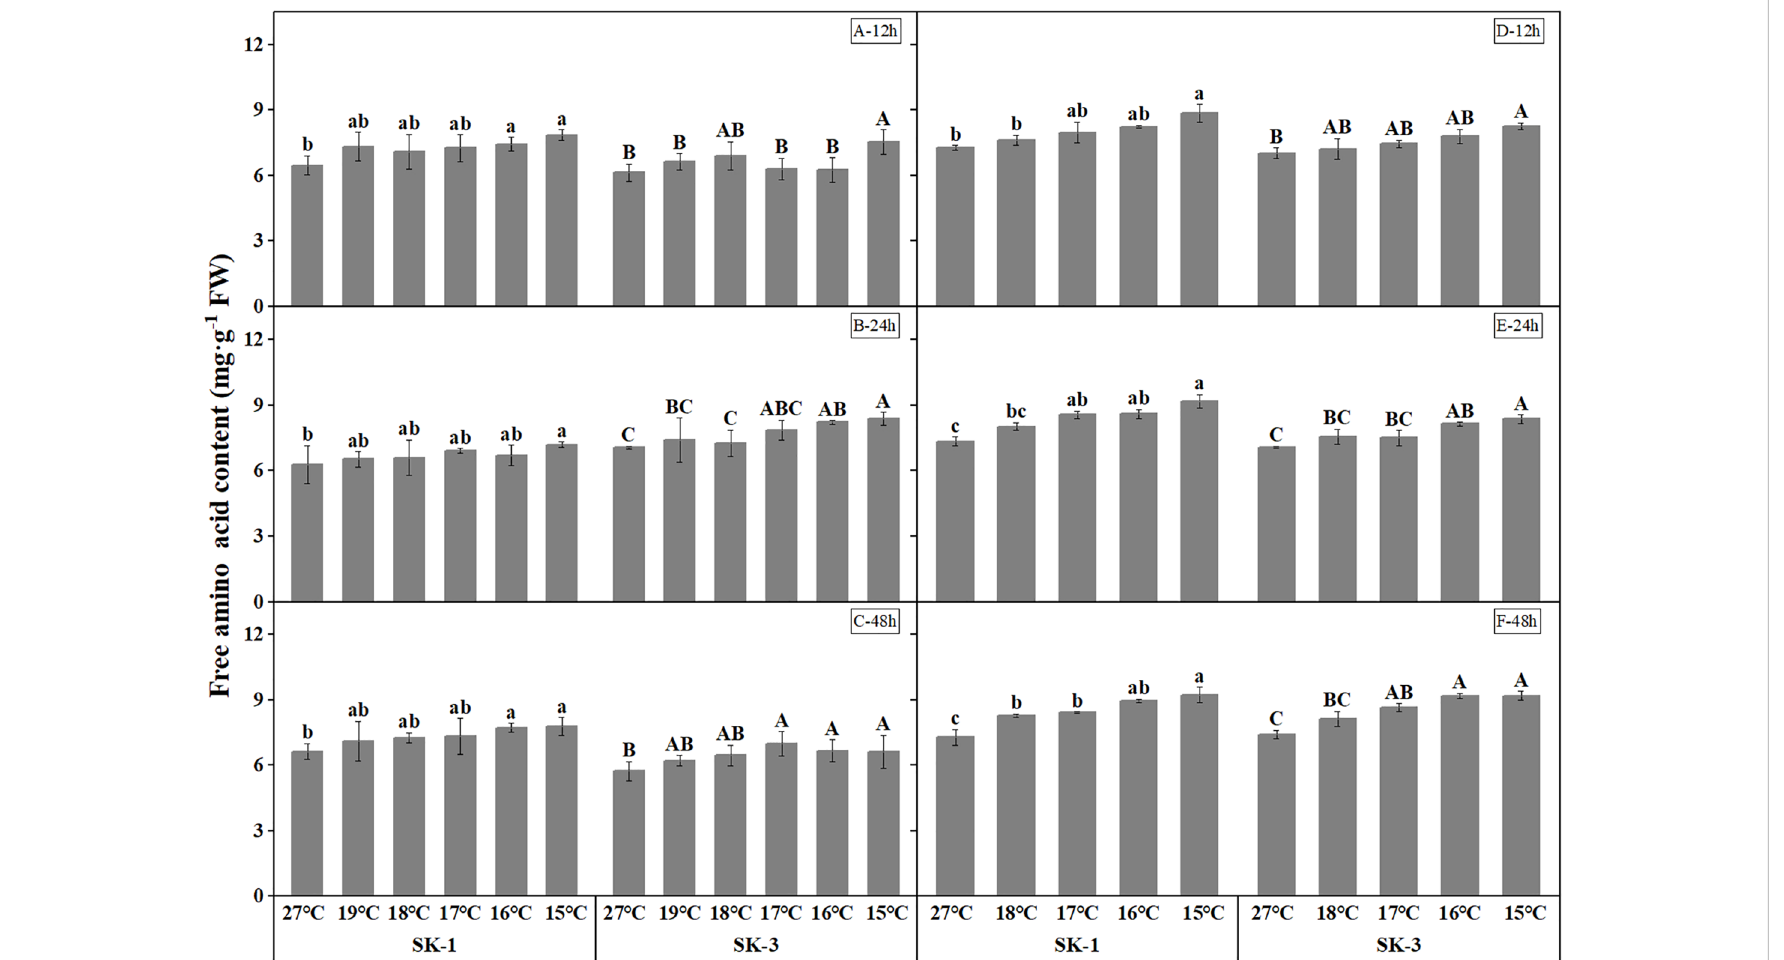
FIGURE 8 Effect of low temperature stress on free amino acid content in cotton squares in 2020 ( A-C : 12h, 24h, 48h stress) and 2021 ( D-F : 12h, 24h, 48h stress). FW represents fresh weight. Different lowercase letters indicate the signi fi cant differences between the treatments of the variety SK1, and different capital letters indicate the signi fi cant differences between the treatments of the variety SK3